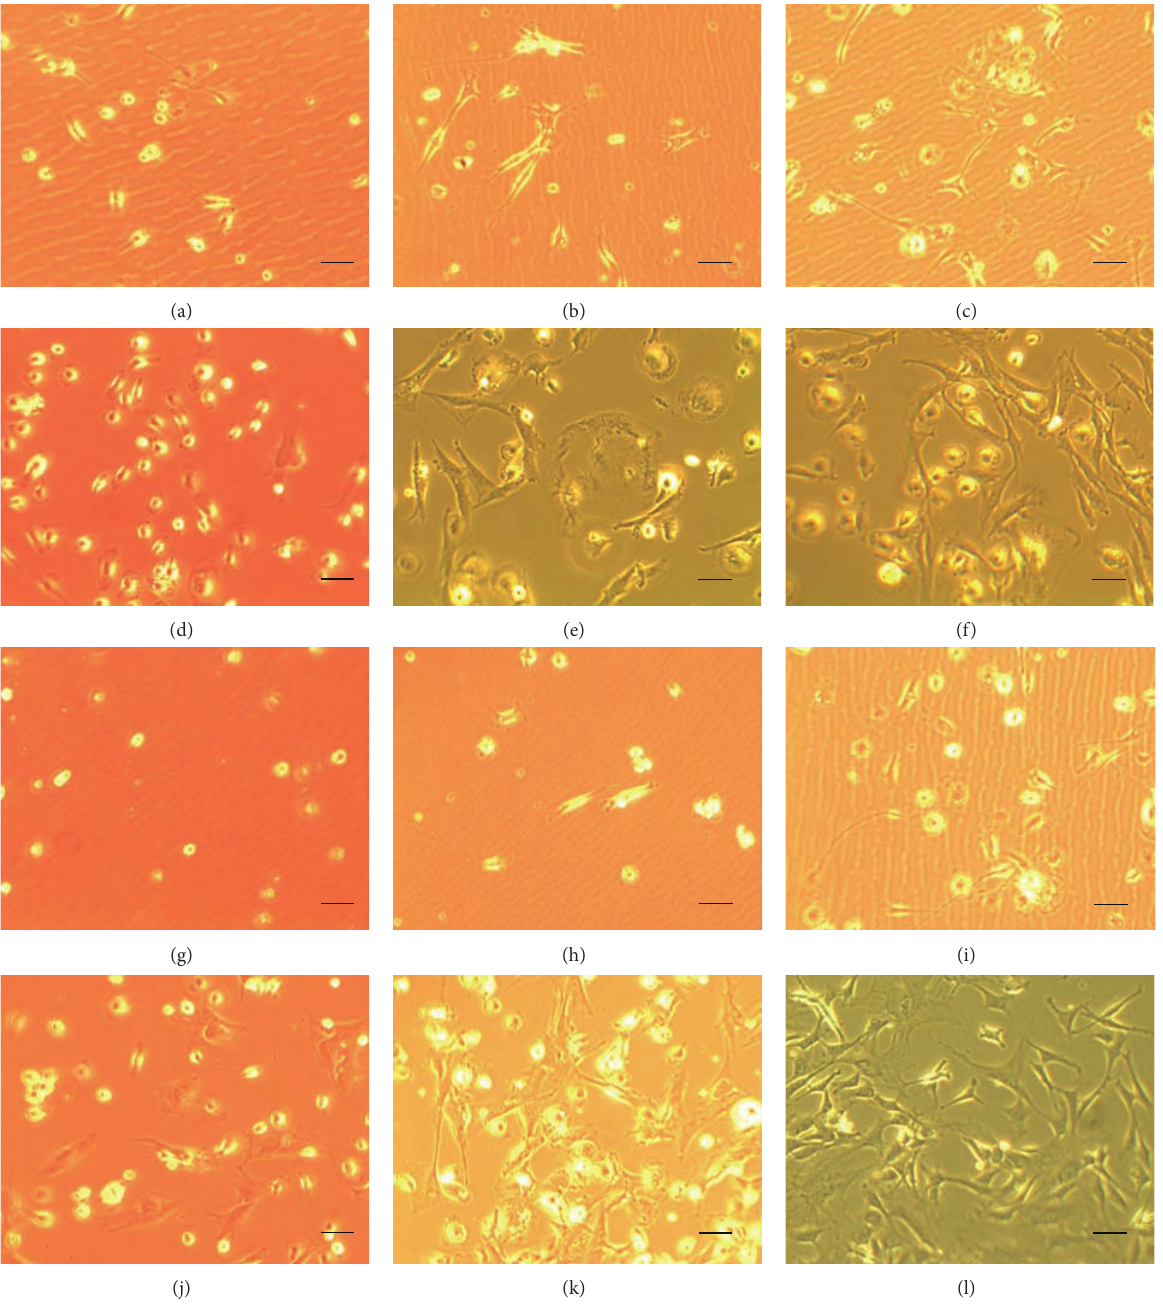
Figure 3: Morphology of mesenchymal cells in the experimental groups after observation for 72 hours. group 1: (a) 24 hours, (b) 48 hours, and (c) 72 hours; group 2: (d) 24 hours, (e) 48 hours, (f) and 72 hours; group 3: (g) 24 hours, (h) 48 hours, and (i) 72 hours; group 4: (j) 24 hours, (k) 48 hours, and (l) 72 hours. Scale: 100 𝜇